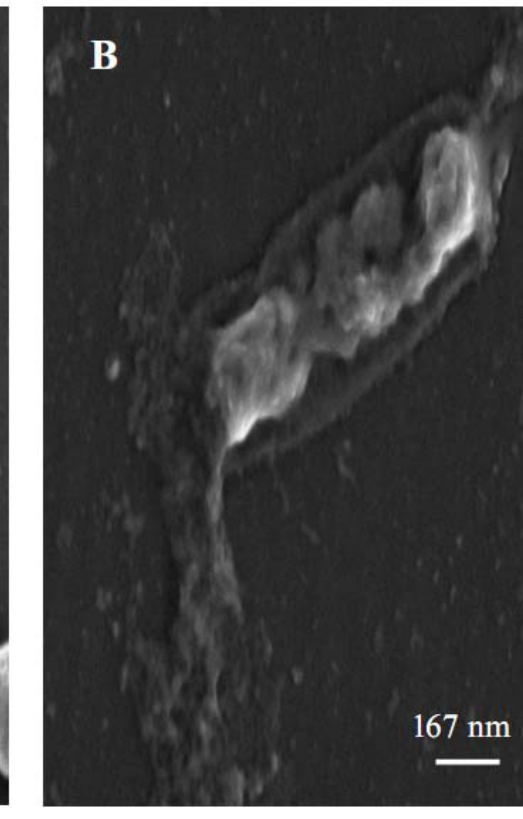
Figure 3. Scanning electron micrograph of Bacillus cereus cells. ( A ) Untreated cells; ( B ) Cells treated with 62.5 µg/mL 3,3 ′ -di- O